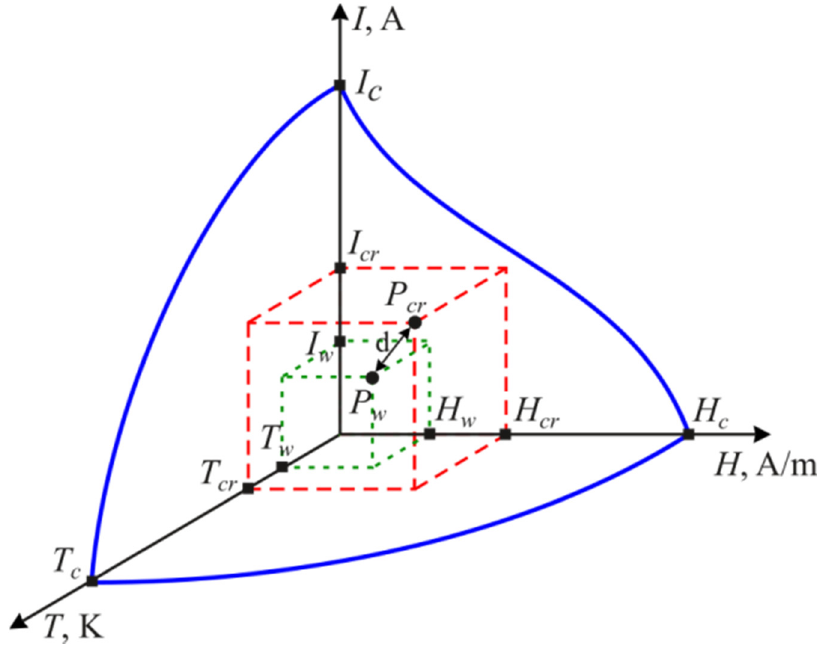
Figure 2. Critical surface of a superconductor.